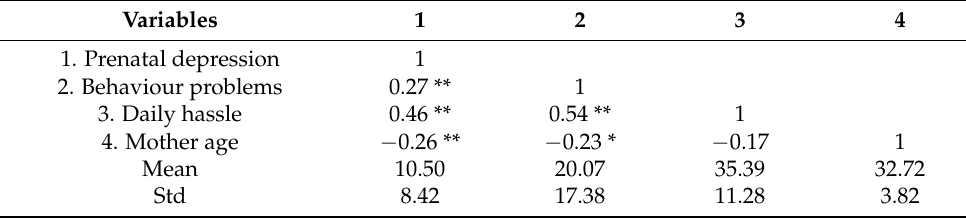
Table 2. Correlation coefficients and descriptive statistics of variables (N = 105).